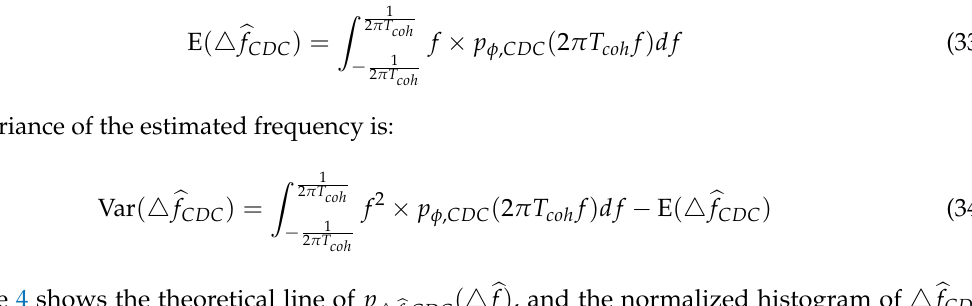
Figure 4a, and (cid:52) f = 250 Hz in Figure 4b. The matching between pdfs and the histograms validates the theoretical analysis